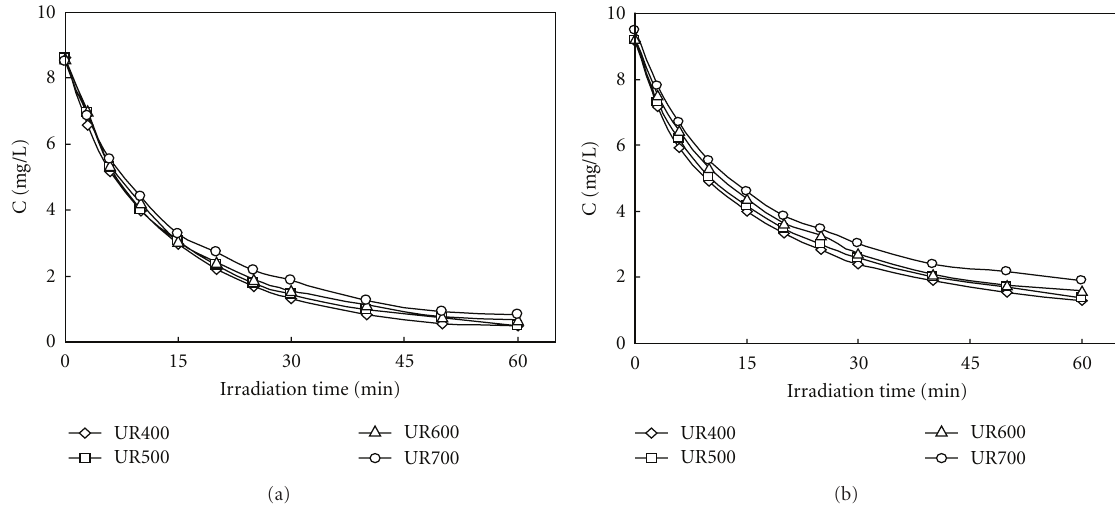
Figure 9: Photocatalytic degradation of (a) p-nitrophenol and (b) methyl orange under ultraviolet using UR400, UR500, UR600, and UR700 as